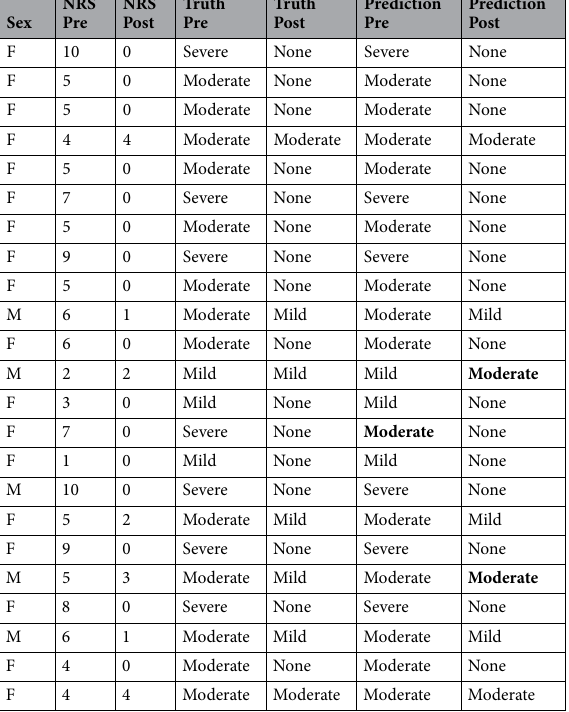
Table 5. Pain levels were determined by NRS at pre and posy surgery, and subdivided into truth None, Mild, Moderate and Sever. Pain levels were also predicted by machine learning, and subdivided into quartile, and were compared with those by NRS. Bold indicate prediction discrepancies between NRS and EEG